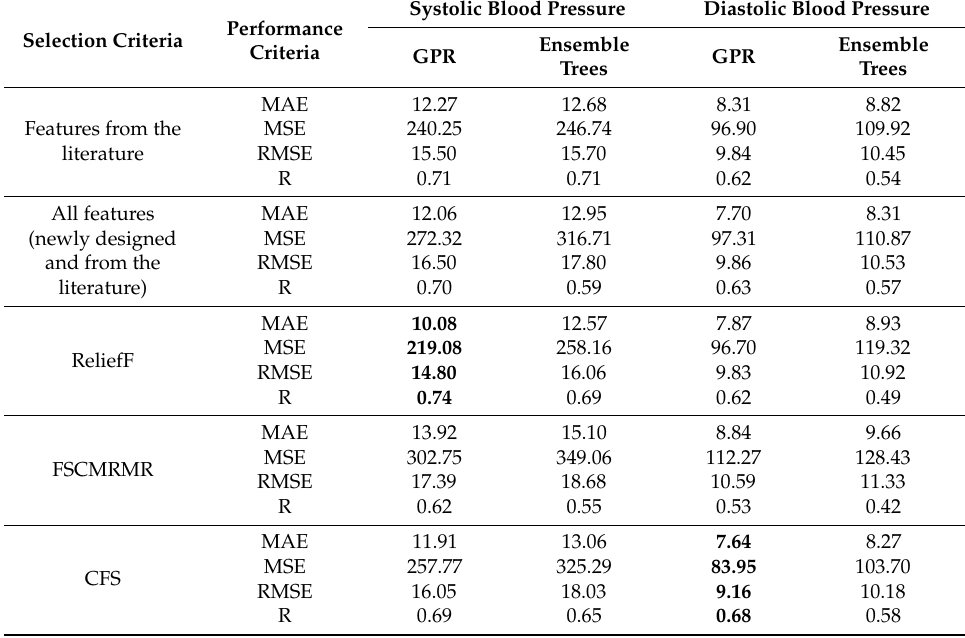
Table 10. Evaluation of the best performing algorithm for systolic blood pressure (SBP) and diastolic blood pressure